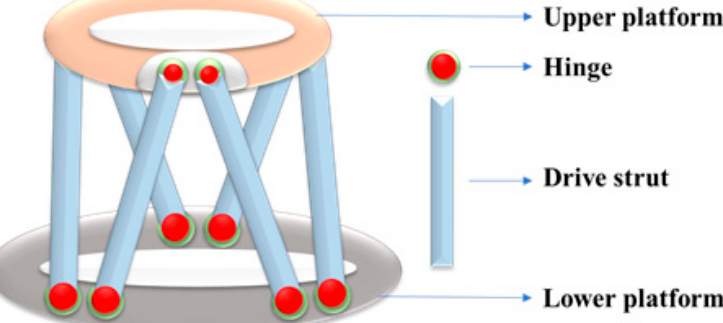
Figure 9. Six–degree–of–freedom parallel Stewart